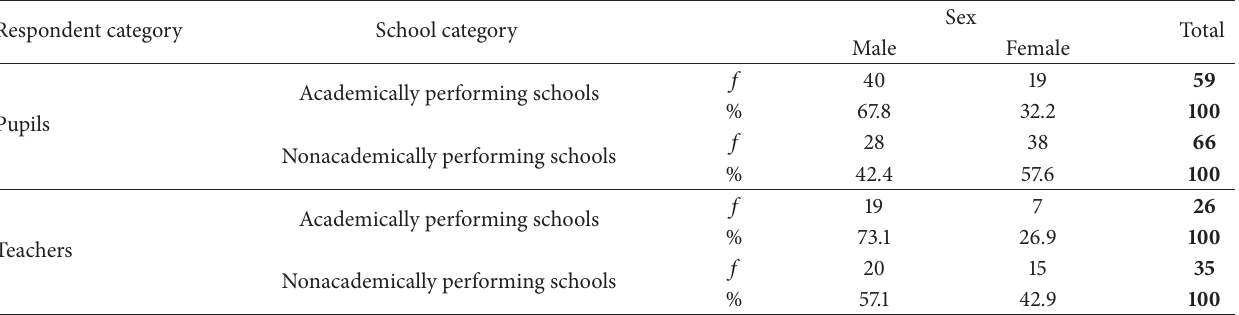
Table 3: Background characteristics of